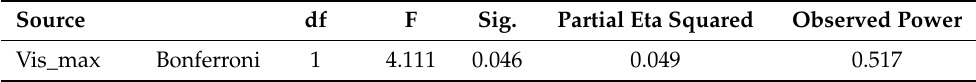
Table 11 represents the outcomes for parametric tests of between-subjects effects. Table 11. Tests of between-subjects effects.